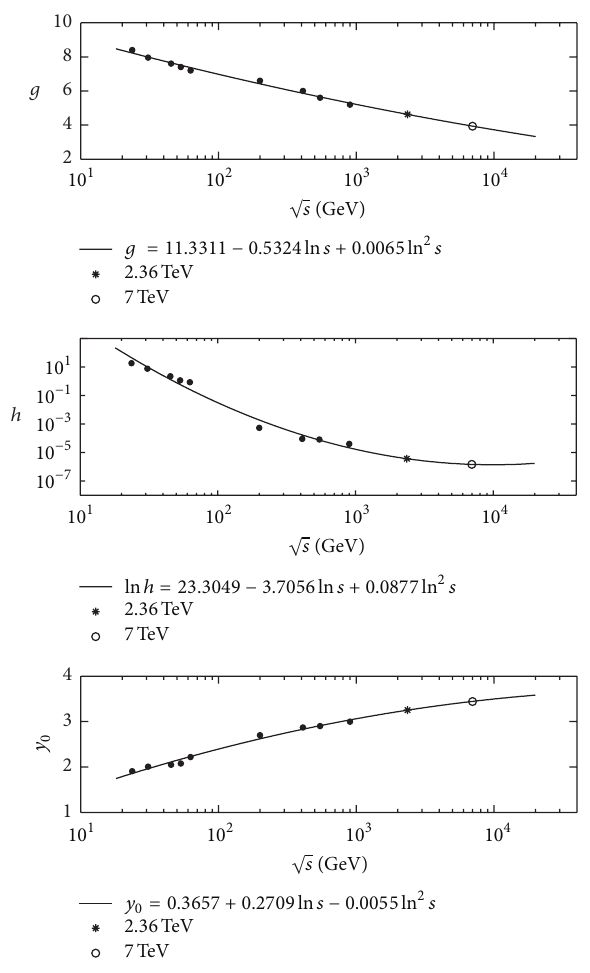
Figure 5: The variations of 𝑔 , ℎ , and 𝑦 0 against √𝑠 . The solid dots represent the fitted values given in the text. The stars and circles are the predictions for p-p collisions at CERN-LHC energies of √𝑠 = 2.36 and 7 TeV, respectively.